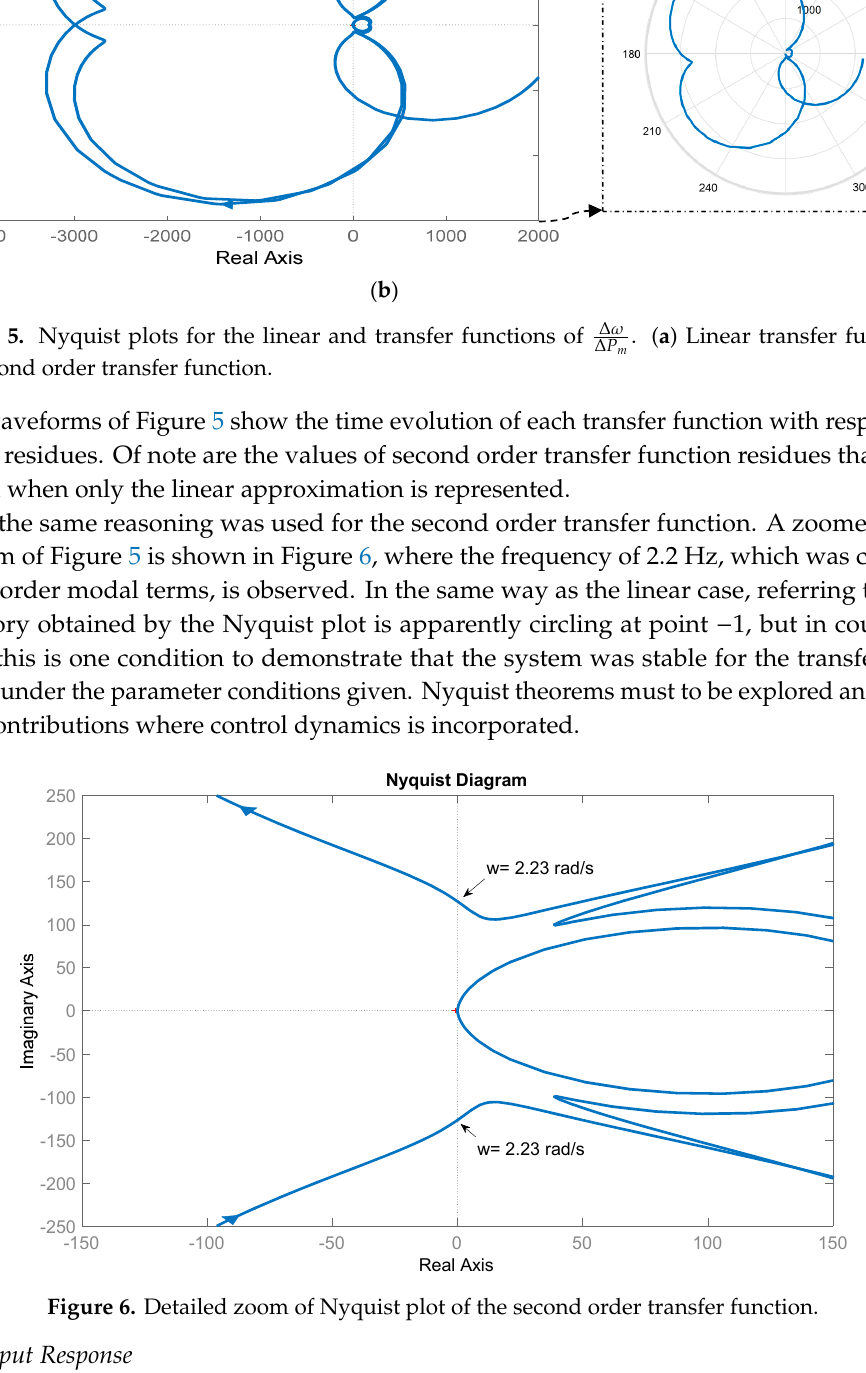
ωΔ ωΔ Δ . ( a ) Linear transfer function; . ( a ) Linear transfer function; P Δ . ( a ) Linear transfer function; 452 P m P m m